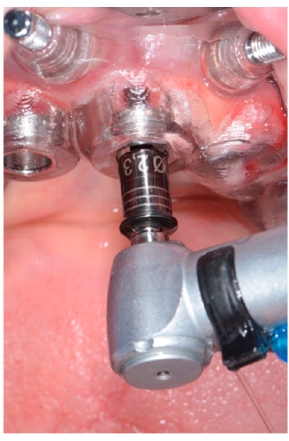
Figure 9. Flapless surgery.